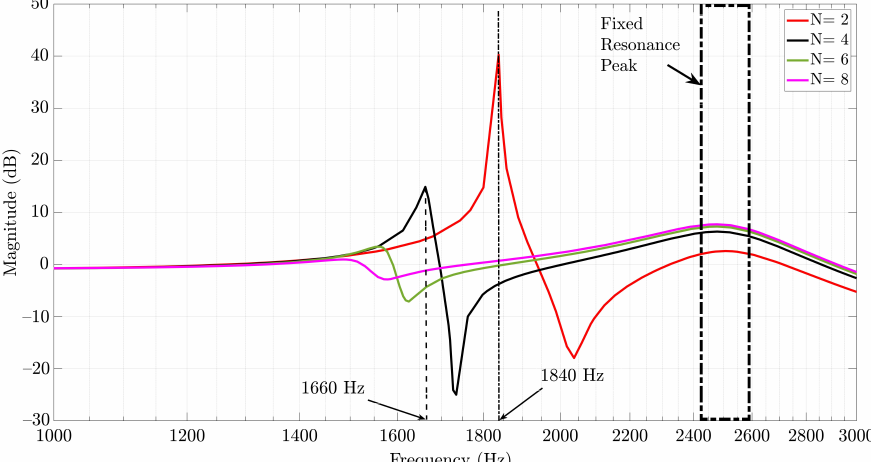
Figure 10. Main current resonance of the inverter itself in a multi–parallel inverter